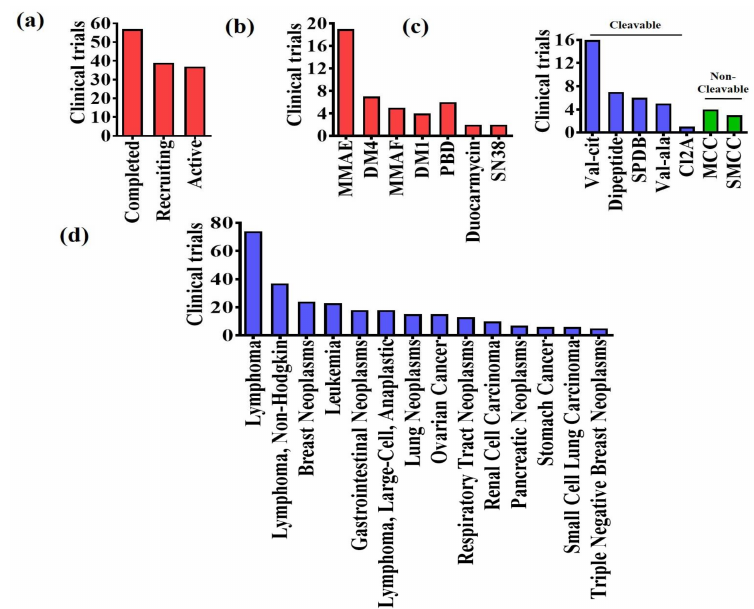
Figure 5. ( a ) Status of clinical trials on ADCs; ( b ) Different ADC payloads in clinical trials; ( c ) Different ADC linkers in clinical trials; ( d ) Clinical trials of ADCs for different type of oncologic indications based on clinicaltrials.gov database